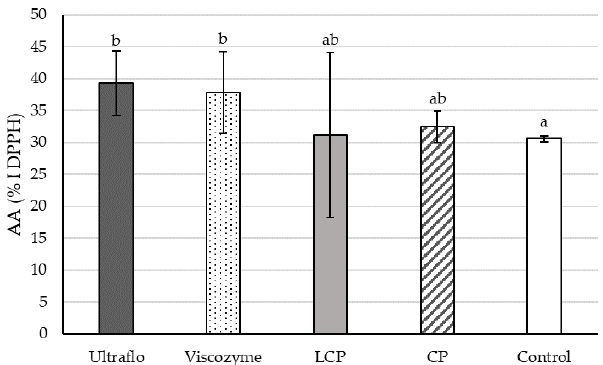
Figure 8. The DPPH-radical scavenging capacity (AA, %I DPPH) in ethanolic extracts plotted as a function of the different enzymatic cocktails. ( a ) pH (4 – 6), ( b ) temperature (30 – 50 °C), and ( c ) time (0.5 – 2.5 h). In order, two commercial cocktails: Ultraflo© (Ultraflo) and Viscozyme© (Visco); three formulated cocktails with laccase, cellulase, and pectinase at propor- tions of 1:1:1 (LCP), 1:1:2 (LCPP), and 0:1:2 (CPP); and the control without added enzymes (No). The color scale indicates the significance of the analysis of variance for the Taguchi method ( p > 0.05).